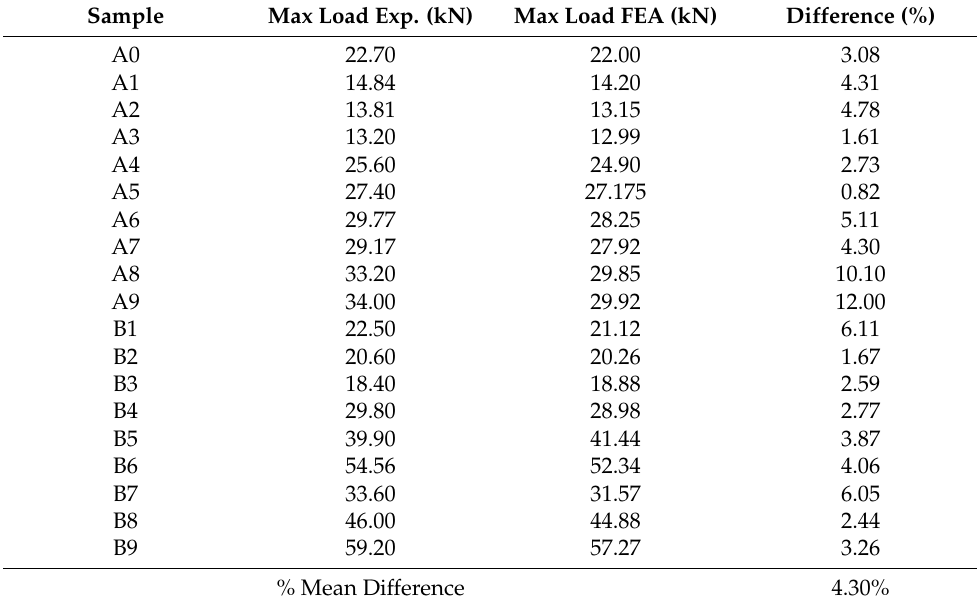
Table 12. Comparison between max load results of the nineteen tested